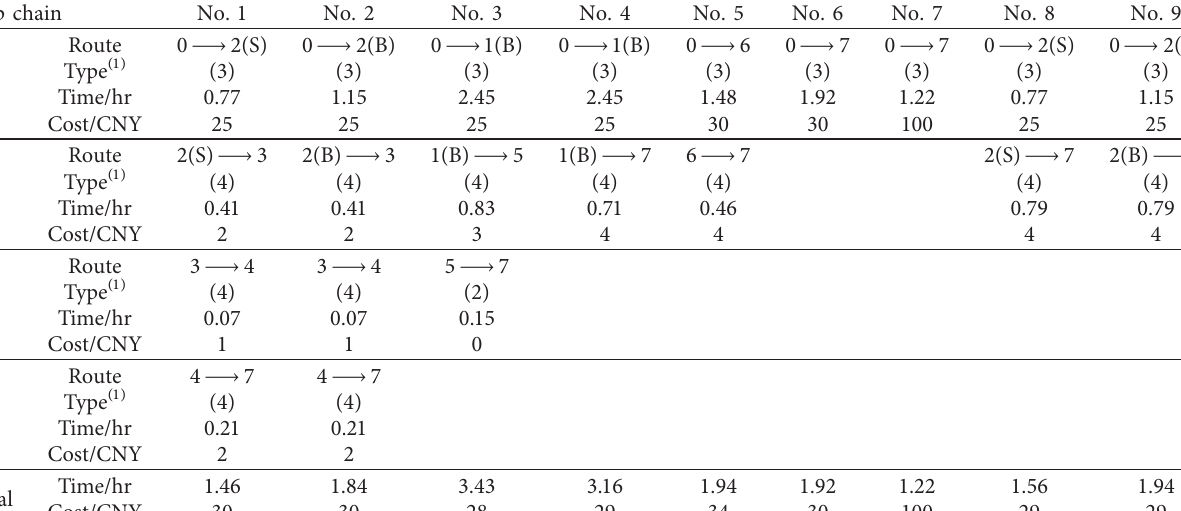
Table 3: Travel information of every segment of each trip